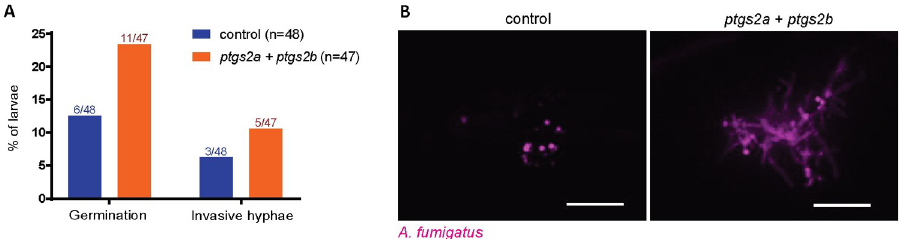
Fig 6. Loss of functional ptgs genes decreases immune control of fungal germination and invasive hyphae. Embryos were injected with gRNAs targeting ptgs2a and ptgs2b or control gRNAs for gfp and Cas9 protein. F0 crispant larvae were then injected with GFP-expressing TBK1.1 (Af293) spores at 2 dpf and imaged at 3 dpi. (A) Percentage of larvae with germination or invasive hyphae. Data are pooled from two independent replicates, at least 23 larvae per condition, per replicate. Average injection CFUs: control = 38, ptgs2a/2b = 39. (B) Representative images showing hyphal growth in each condition. Scale bar = 50 μ m.